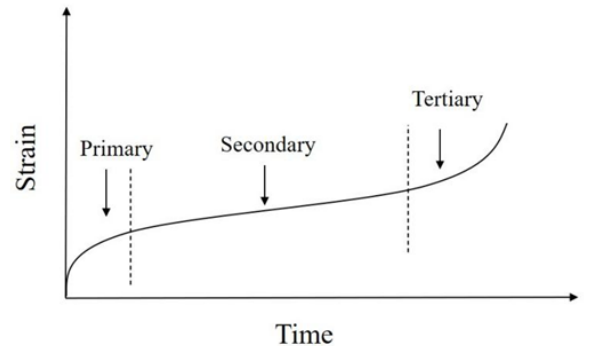
Figure 3. Three stages of creep behavior .